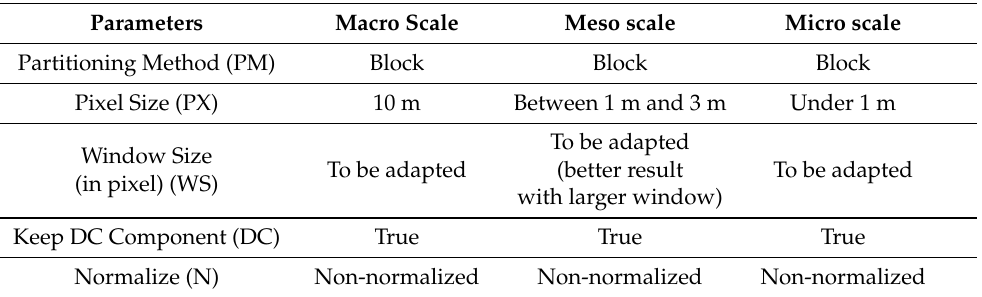
Table 5. Summary of the recommendations for the choice of the optimal parameters to be used in FOTOTEX for the study of the urban landscapes at three different scales. Parameters Macro Scale Meso scale Micro scale Partitioning Method (PM) Block Block Block Pixel Size (PX) 10 m Between 1 m and 3 m Under 1